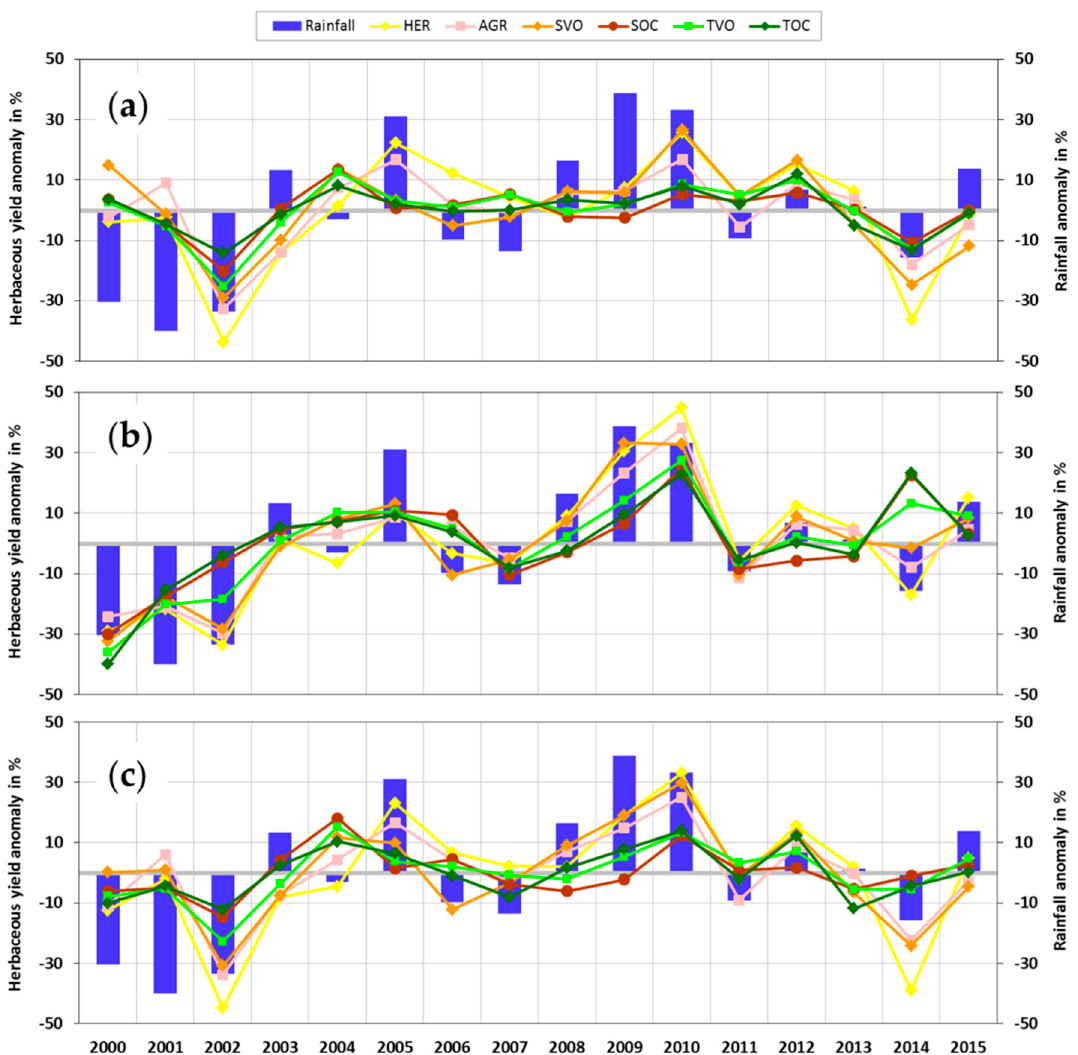
Figure 9. Inter-annual variations in rainfall and estimated herbaceous yield over the whole study area from the: ( a ) VI-model; ( b ) AGRO-model; ( c ) VIAGRO-model. Rainfall values were averaged from the 24 monitoring sites and the estimated herbaceous yield was averaged from all pixels covered by a given class. Colors and acronyms are explained in Figure 8 and Table 1.